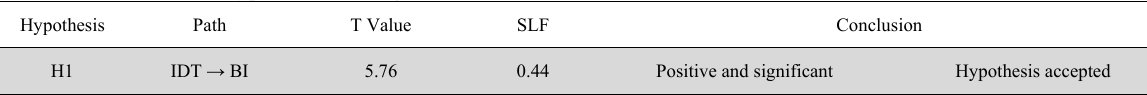
Results of Direct Effect Hypothesis Testing